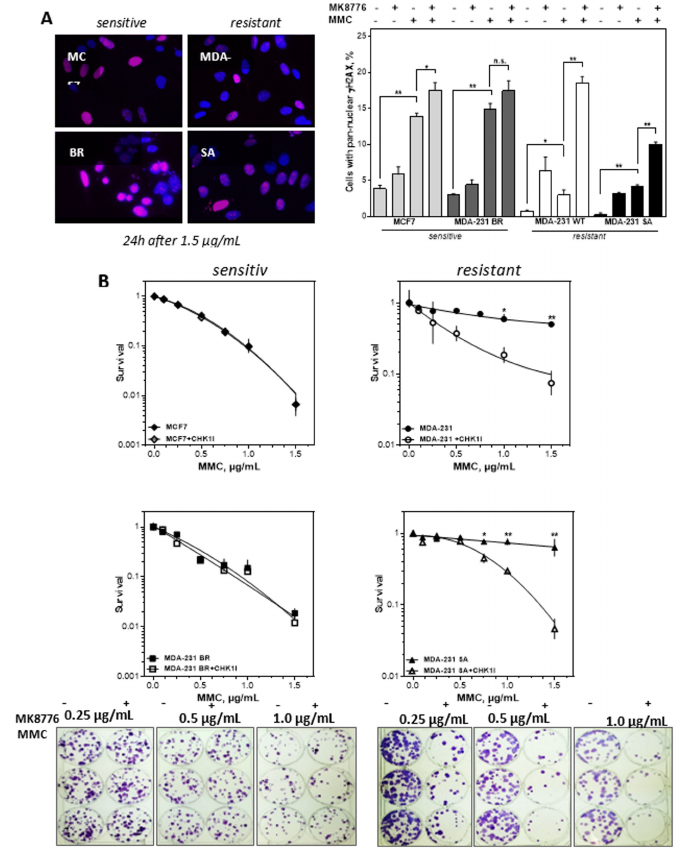
Figure 5. CHK1 inhibition sensitizes only cells with resistance towards